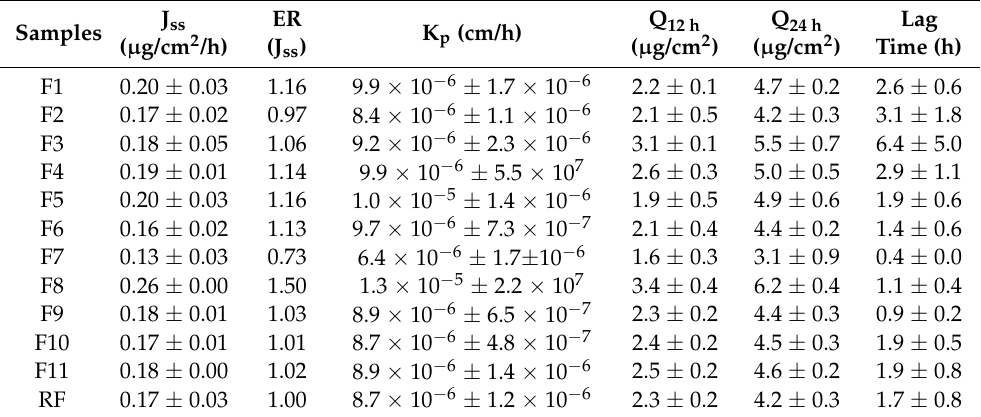
Table 1. Permeation parameters according to experimental permeation data of DoE formulations and RF. Data are mean ± SD, n =